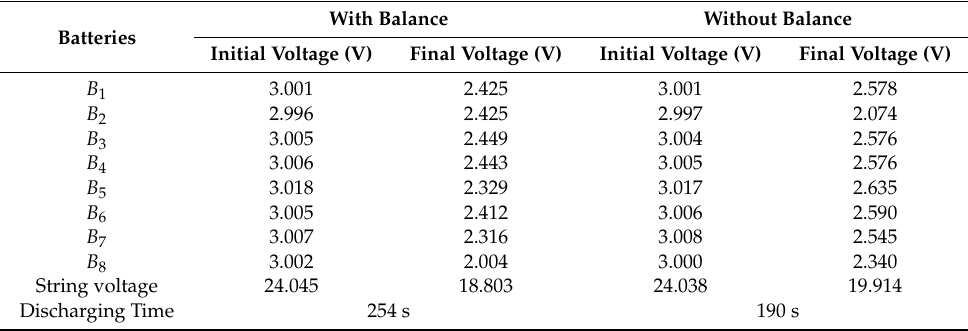
Table 3. Battery voltage during discharging with and without the balance operation.